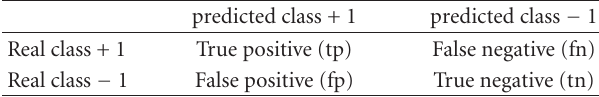
Table 1: The confusion matrix for a binary classification